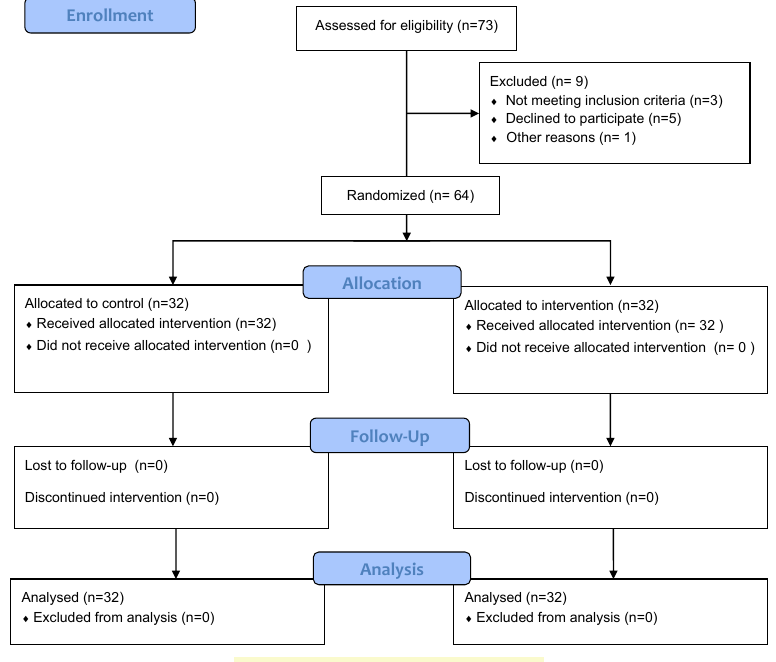
Figure 1. The Flowchart of the study.